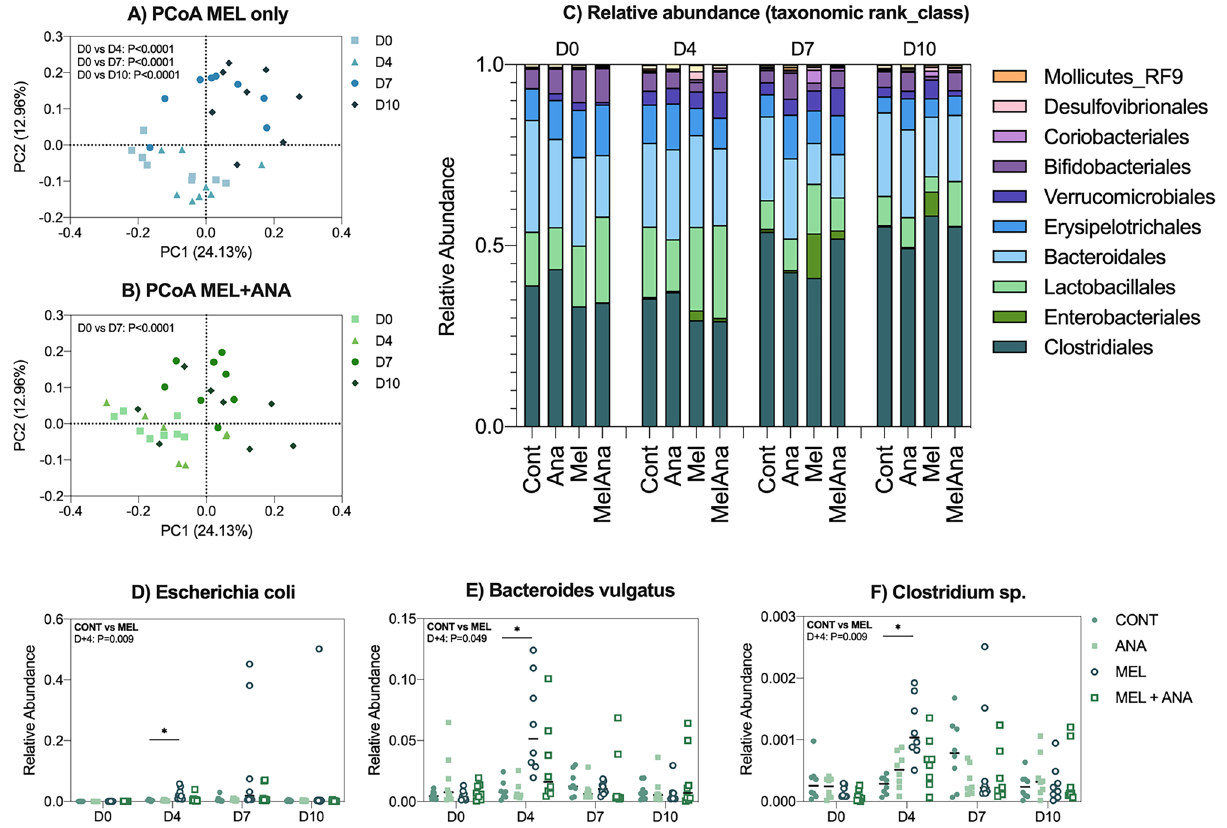
Figure 4. Anakinra reduces mucosal barrier injury-associated dysbiosis and controls enteric pathogen expansion. Melphalan caused compositional changes in the fecal microbiota that persisted for the entire experimental period ( A ). MEL + ANA rats only showed significant PCoA changes at day 4 ( B ). Taxonomic analysis ( C ) showed expansion of Enterobacteriales in MEL only rats, with increases in E.Coli ( D ), Bacteroidetes vulgates ( E ) and Clostridium sp ( F ). Data shown as individual samples, with the exclusion of Panel C which shows mean relative abundance. N = 8/group, all analyzed longitudinally via repeated stool collection. All statistical analyses for microbiota data are outlined in supplementary